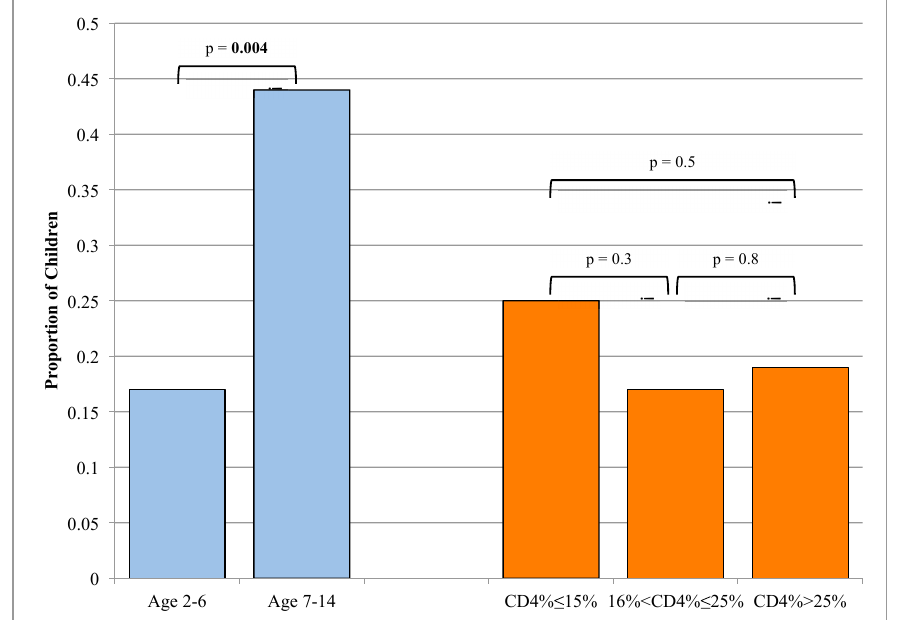
Figure 1 Proportion of children who did not meet energy recommendations by age and